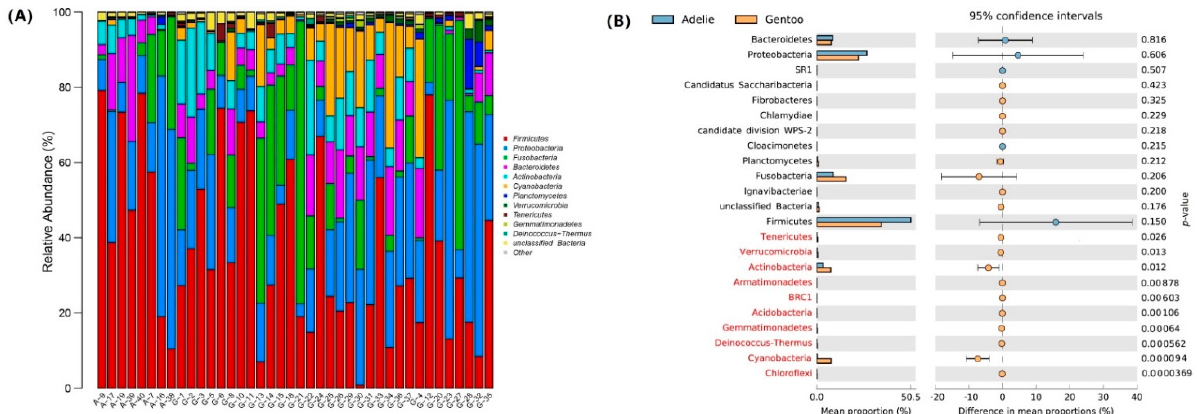
Figure 3. Bacterial community composition in pygoscelid penguin feces. ( A ) Distribution of bacterial taxa at the phylum level in penguin feces. “Other” indicates the sum of phyla that represented less than 1% of the total bacterial sequences in the feces. ( B ) Difference in bacterial abundance in fecal microbiota at the phylum level between Adélie and Gentoo groups. Mean proportions are shown in stacks for Adélie (blue) and Gentoo (orange) groups. Phyla in red indicate statistically significant differences ( p ≤ 0.05).